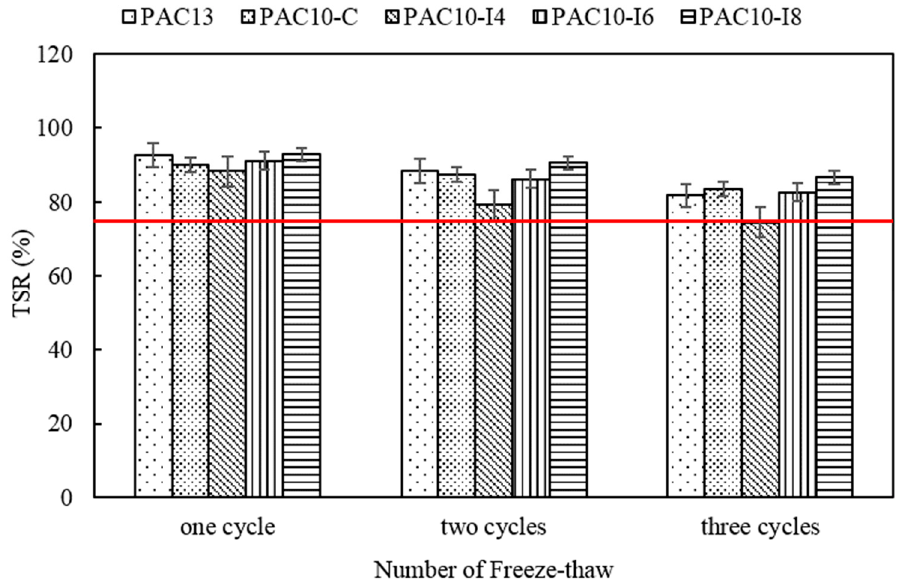
Figure 5. TSR for moisture susceptibility of mixtures.